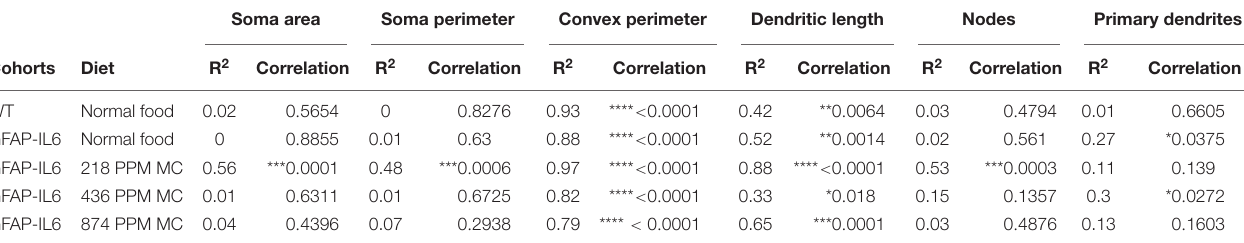
FIGURE 15 | MC increased the ramification of astrocytes in the hippocampus region. (A–F) A Sholl analysis confirmed a significant increase in the number of the intersection, processes length, surface area, and a number of nodes compared with the WT. In contrast, MC significantly affects the inflamed astrocytes, which is observed in the peaks of the distributions of different morphological features being closer to the center compared with the WT and GFAP-IL6 mice, we call it X at Ymax. One-way ANOVA test. Significance = * p < 0.05, ** p < 0.001, *** p < 0.0001, **** p < 0.0001. TABLE 7 | Bivariate correlation of morphological characteristics with overall astroglial cell size in the hippocampus. Soma